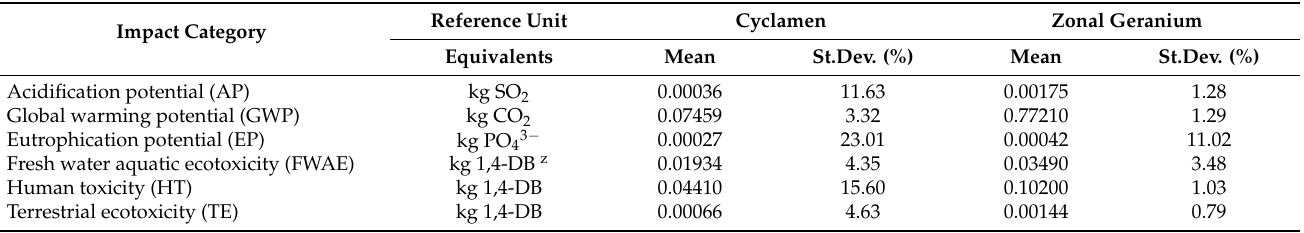
Table 2. Absolute values and standard deviation (in percentage) for the assessed impact categories for flowering potted plants of cyclamen ( Cyclamen persicum Mill.) and zonal geranium ( Pelargonium × hortorum Bailey). Impact